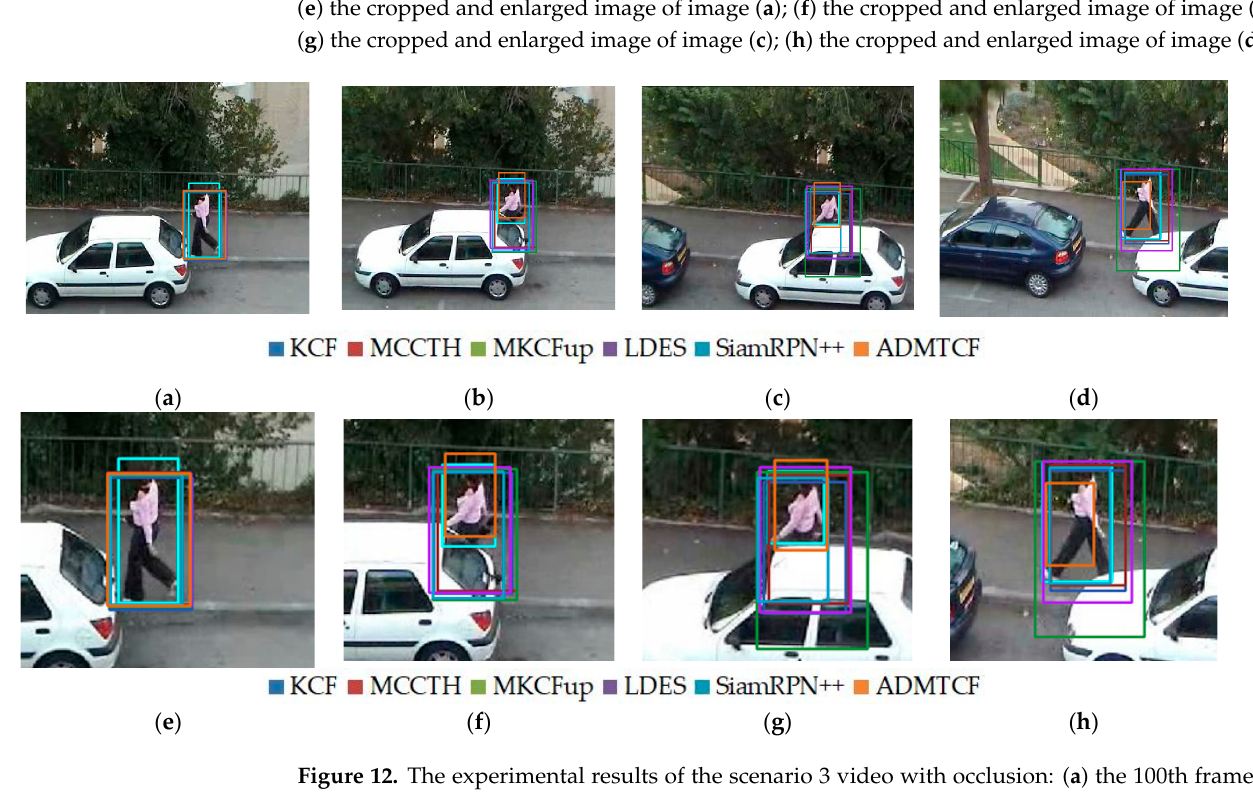
Figure 12. The experimental results of the scenario 3 video with occlusion: ( a ) the 100th frame of the video; ( b ) the 113rd frame of the video; ( c ) the 140th frame of the video; ( d ) the 172nd frame of the video; ( e ) the cropped and enlarged image of image ( a ); ( f ) the cropped and enlarged image of image ( b ); ( g ) the cropped and enlarged image of image ( c ); ( h ) the cropped and enlarged image of image ( d ).